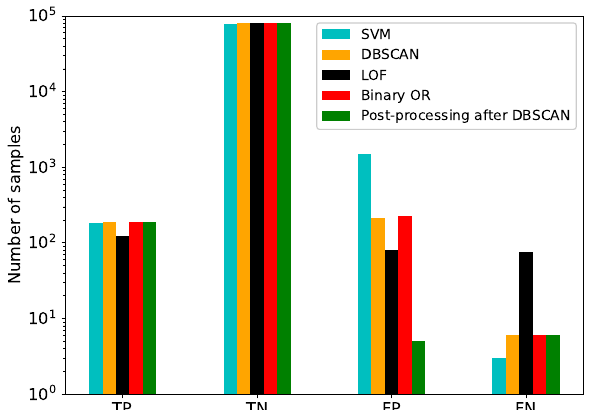
Figure 4. Results from anomaly detection using SVM, DBSCAN, LOF, a binary OR between DB- SCAN and LOF, and post-processing following DBSCAN methods. TP = True Positives (anomaly correctly detected), TN = True Negatives (normal point correctly detected), FP = False Positives, FN = False